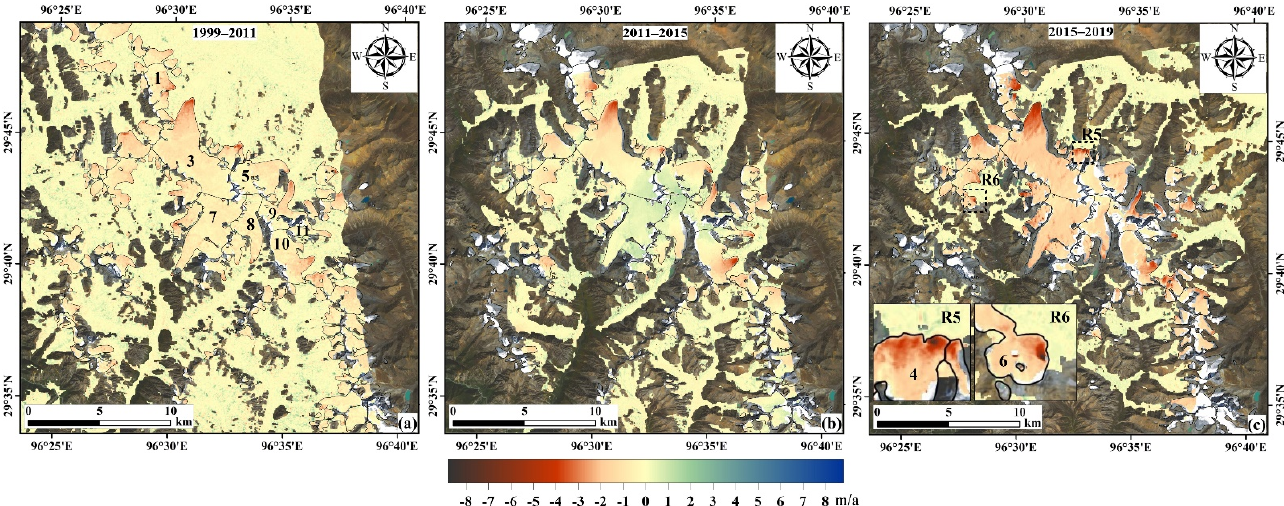
Figure 3. Derived glacier surface elevation change rates in three observation periods. The observation period is marked at the upper-middle part of the subfigure. Black curves denote glacier outlines. Numbers over glacier areas marked the glaciers mentioned in the text. Insert panels in ( c ) are the zoomed-in view of the areas within black dotted rectangles. The background of ( a – c ) is the Landsat − 8/OLI image acquired on 6 October 2015.